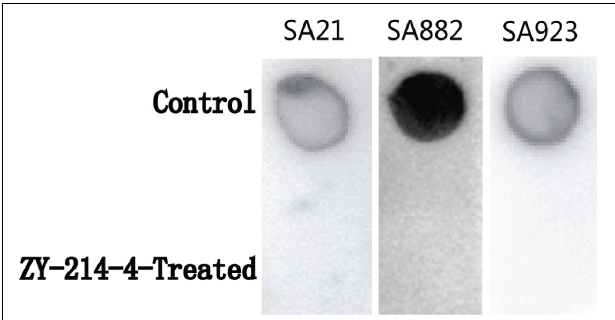
FIGURE 6 | Effect of ZY-214-4 (4 µ g/ml) on S. aureus PIA